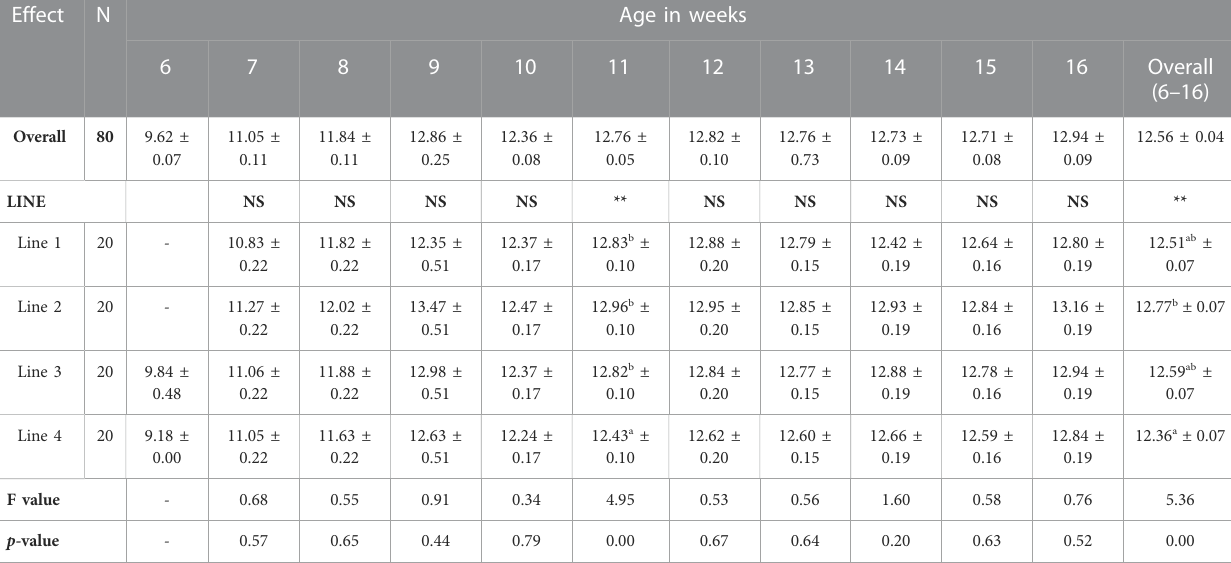
TABLE 7 Means (±S.E.) of egg weight (g) of different lines of Japanese quail from 6th to 16th week of age.